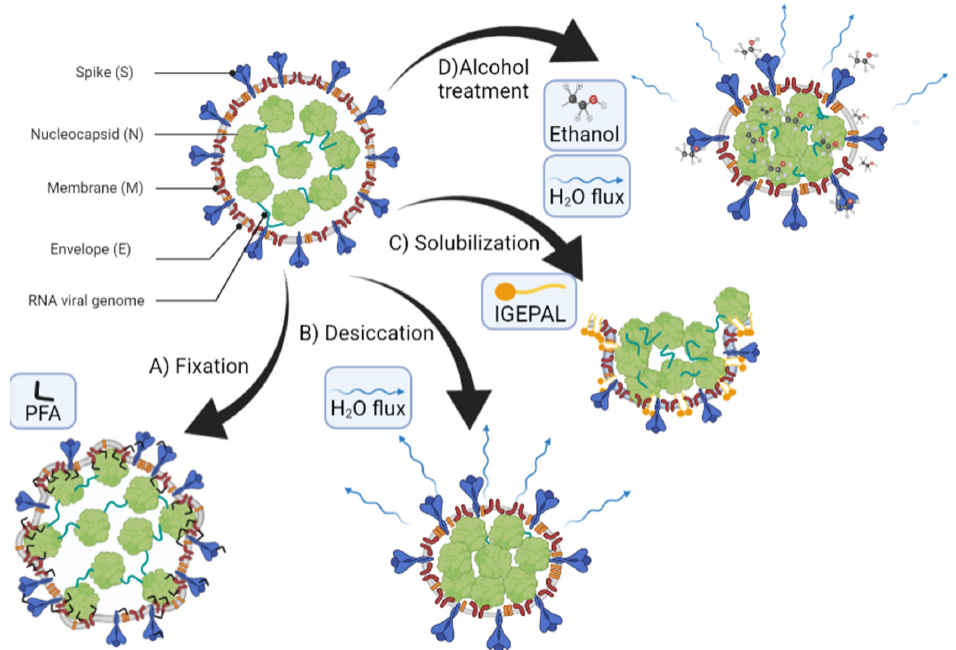
Figure 6. Proposed effects for the different environmental conditions. Paraformaldehyde (PFA) treatment, which fixes the RNPs and membrane proteins to the capsid layer. Desiccation of the viral particle reduces the virion size. IGEPAL solubilizes the membrane lipids while uncovering the core and allows some RNPs to spread out around the virion. Alcohol induces both dehydration and loss of